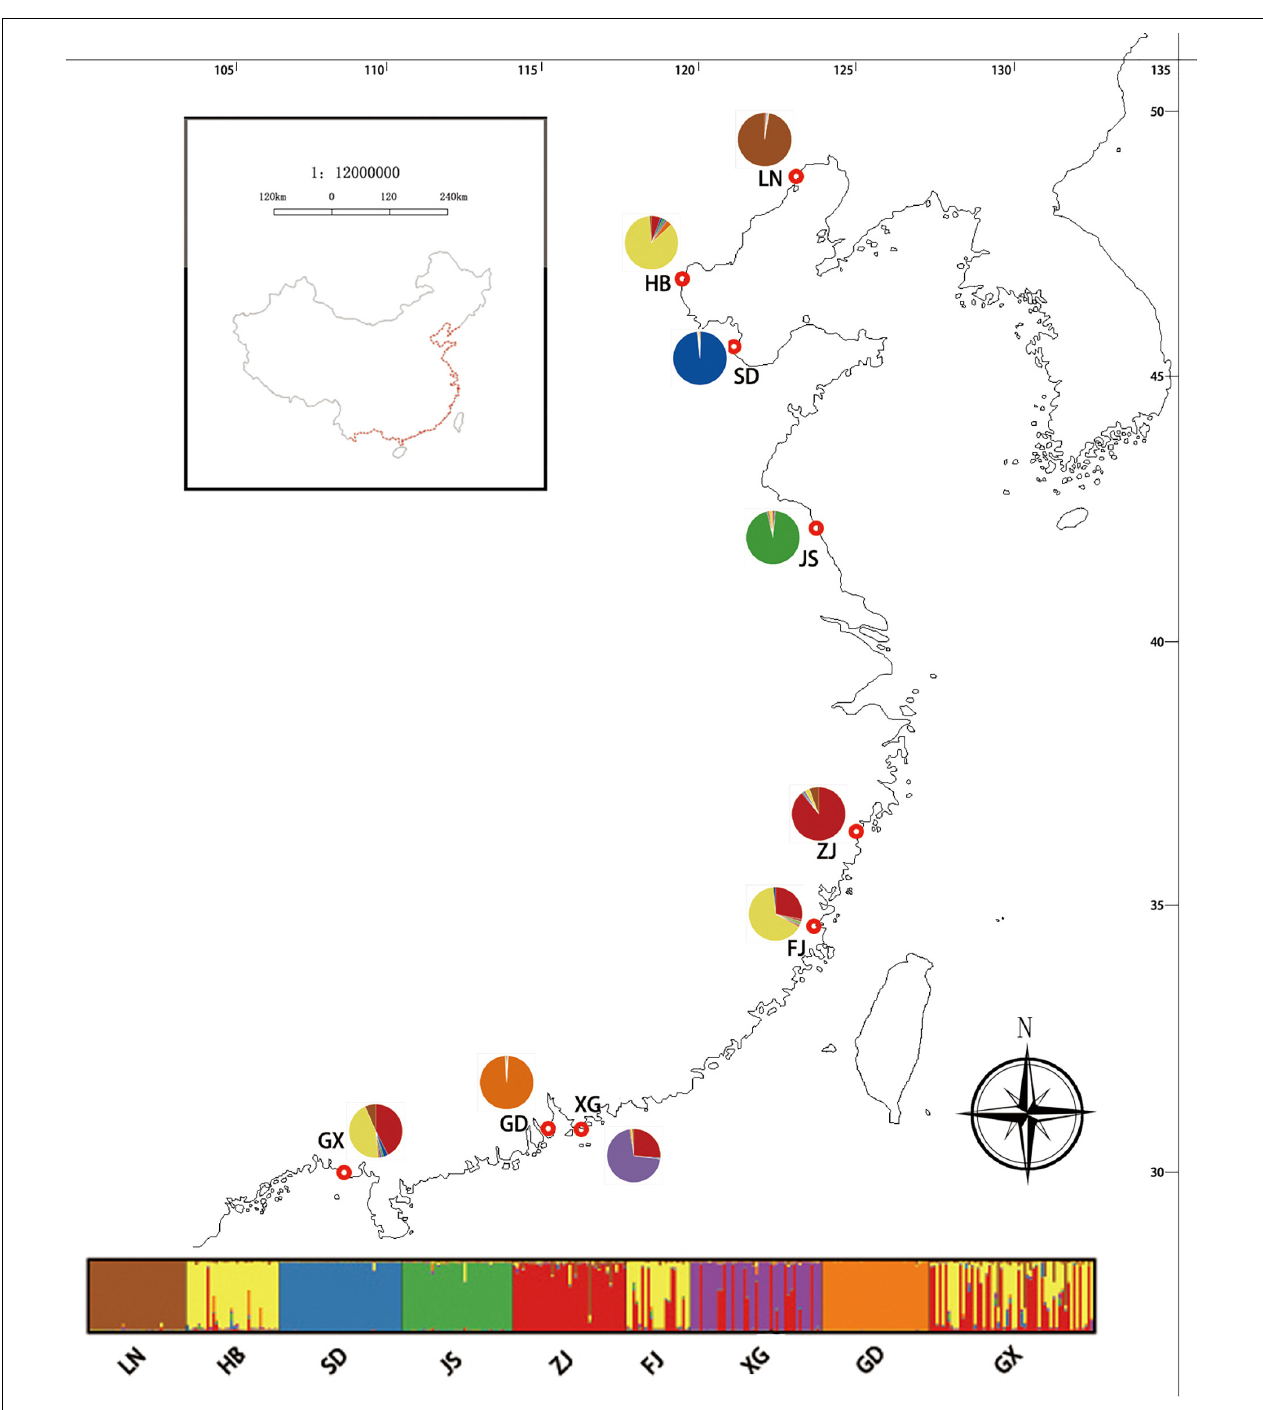
FIGURE 6 | Geographic distribution of the genetic groups on the coast of China detected using STRUCTURE analysis of Spartina alterniflora based on SSR data ( (cid:49) K = 7).